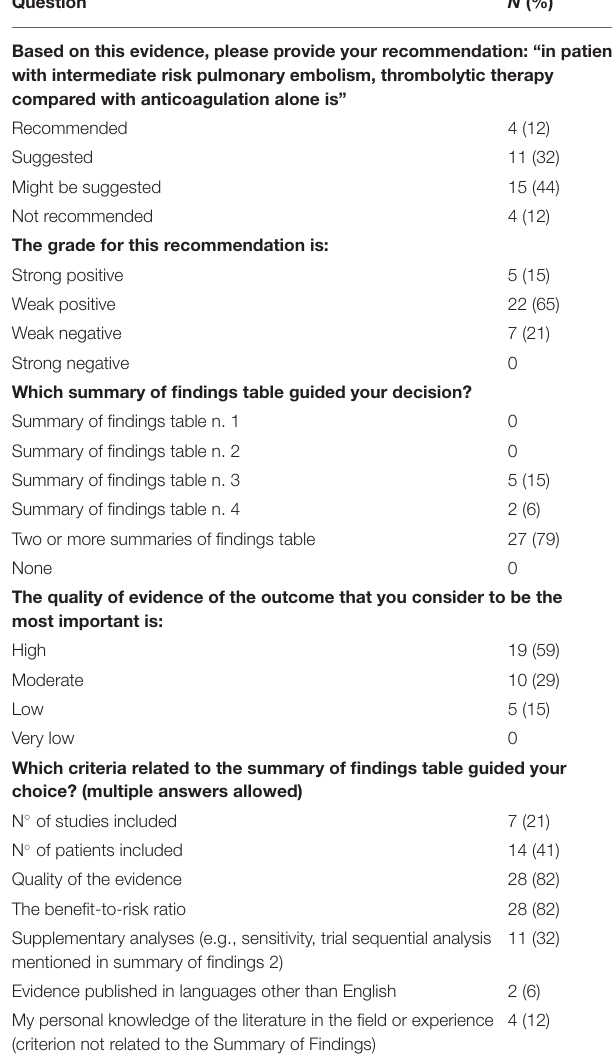
TABLE 2 | Participants’ recommendation regarding the intervention, and rationale behind their decision-making (responses provided by 34 participants).